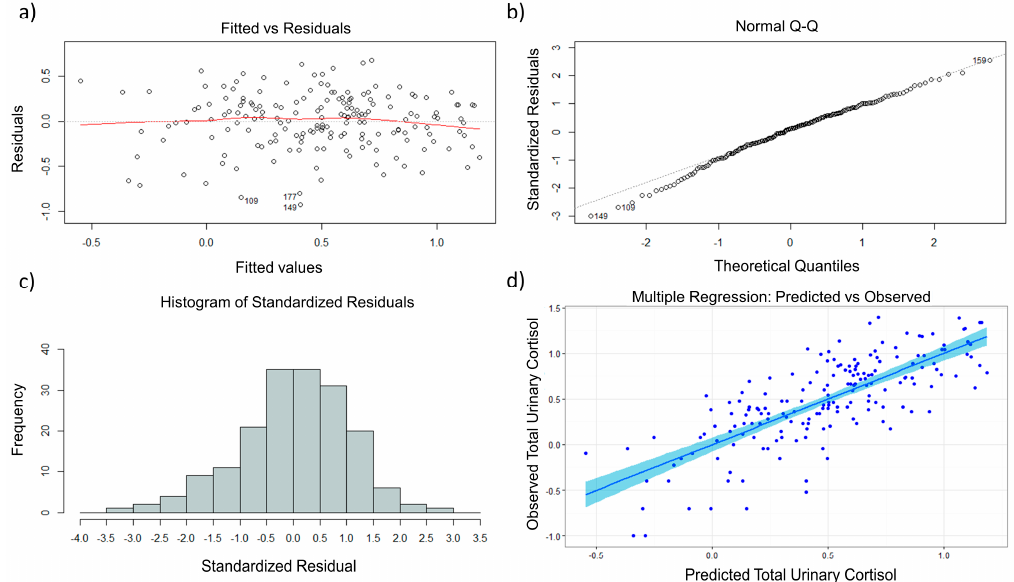
Figure 1. Finalized multiple regression results, using the top 35 variable subset and AICc-guided backward and forward model selection. Both the explanatory and response variables are log 10 transformed. ( a ) The residual vs. fitted plot supporting the assumption of constant variation in error terms; ( b ) the QQ plot supporting the assumption of error term normality; ( c ) histogram of residuals showing normally distributed error terms; ( d ) predicted vs. observed total free cortisol (in µg) using the multiple regression model with the 95% confidence interval shown in light blue, with values reported as log 10 transformed.